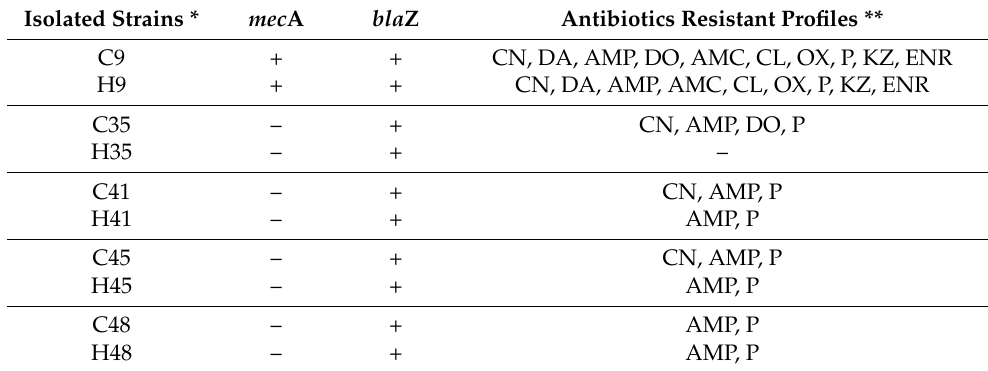
Table 6. Comparison of S. pseudintermedius isolated from dogs and their